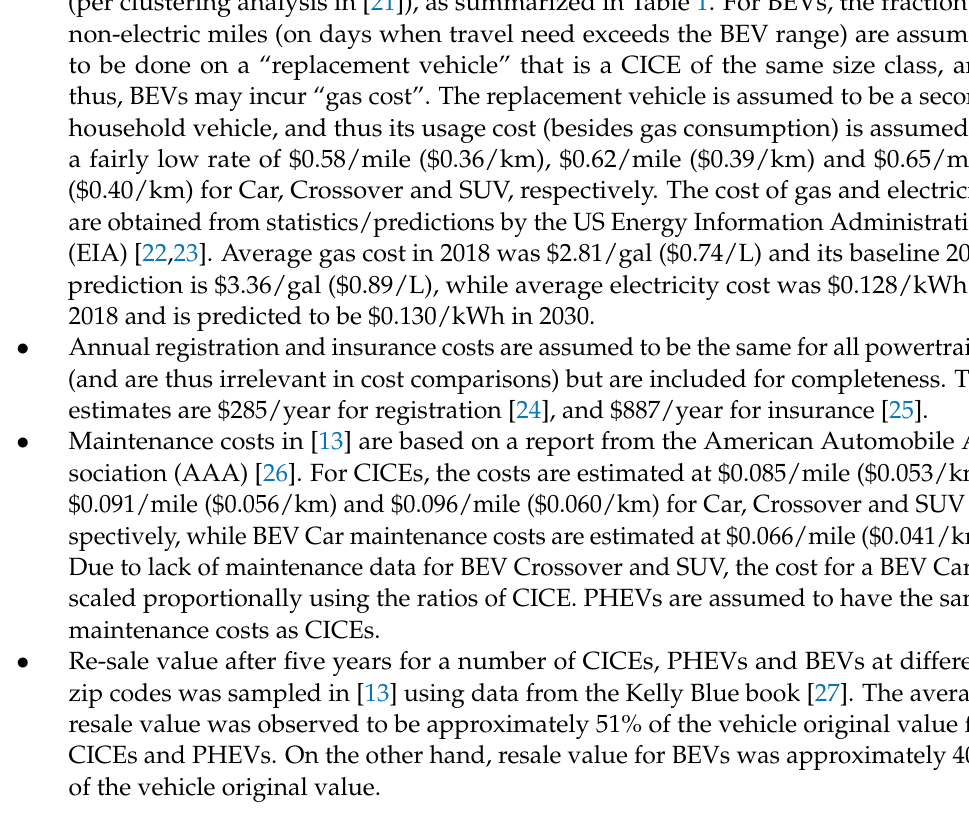
Table 1. Annual vehicle miles travelled (VMT) and utility factor (UF) based on California household travel survey (CHTS)